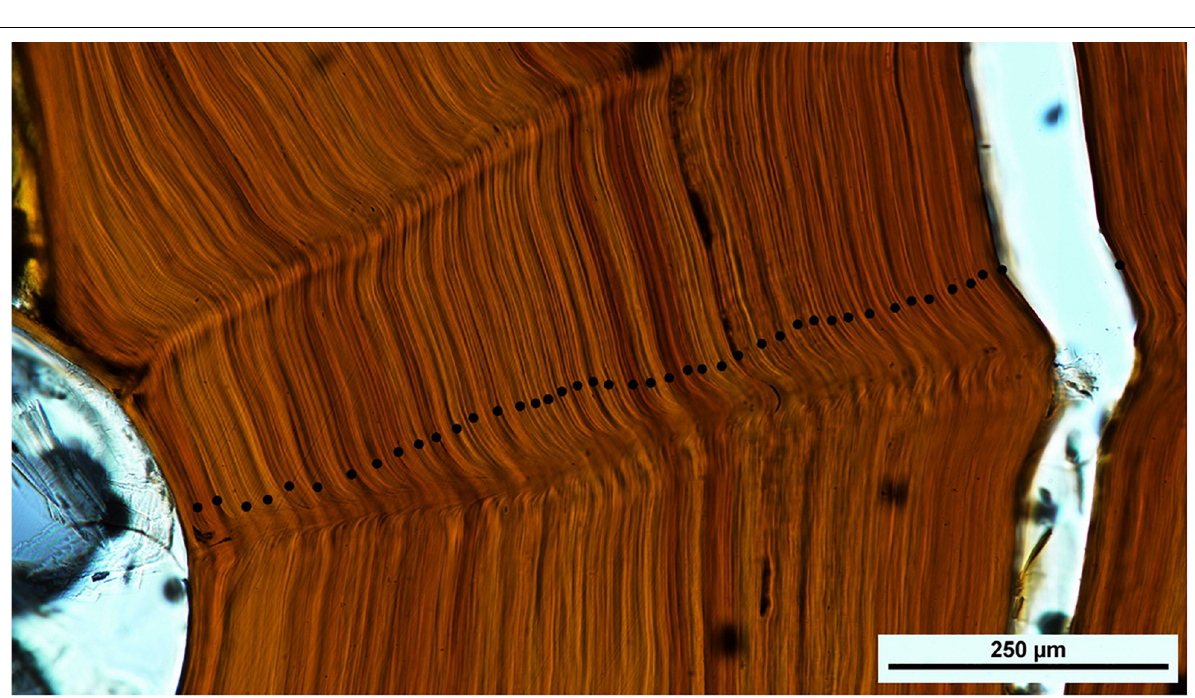
section “ Bathypathes patula Age and Growth Estimates” for a further discussion on zone counting). Growth rates were